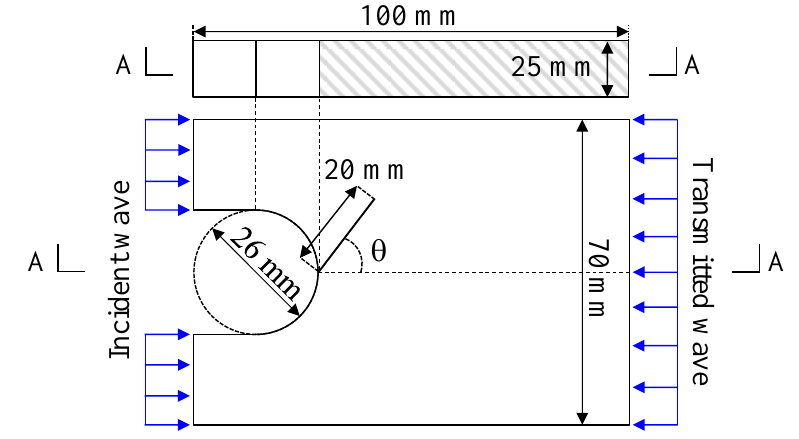
Figure 2. Variable angle single cleavage semi-circle (VASCSC) specimen geometry. Table 1. Material parameters of polymethyl methacrylate (PMMA) in the experiment.